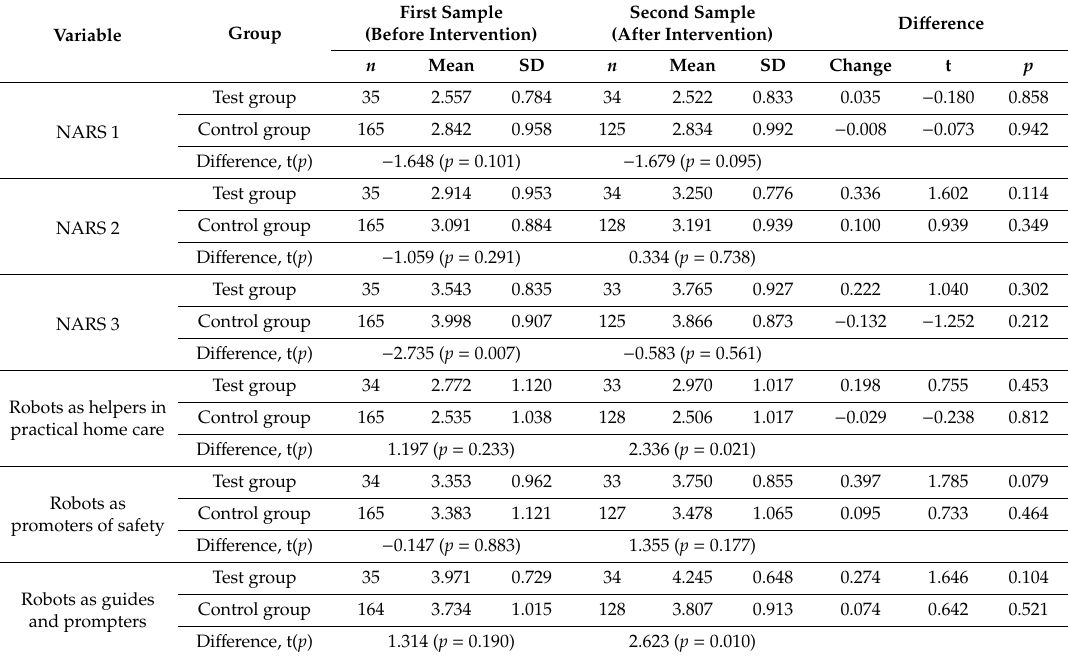
Table6. Di ff erencesinattitudesbetweenthetestgroupandthecontrolgroupinfirstandsecondsamples.